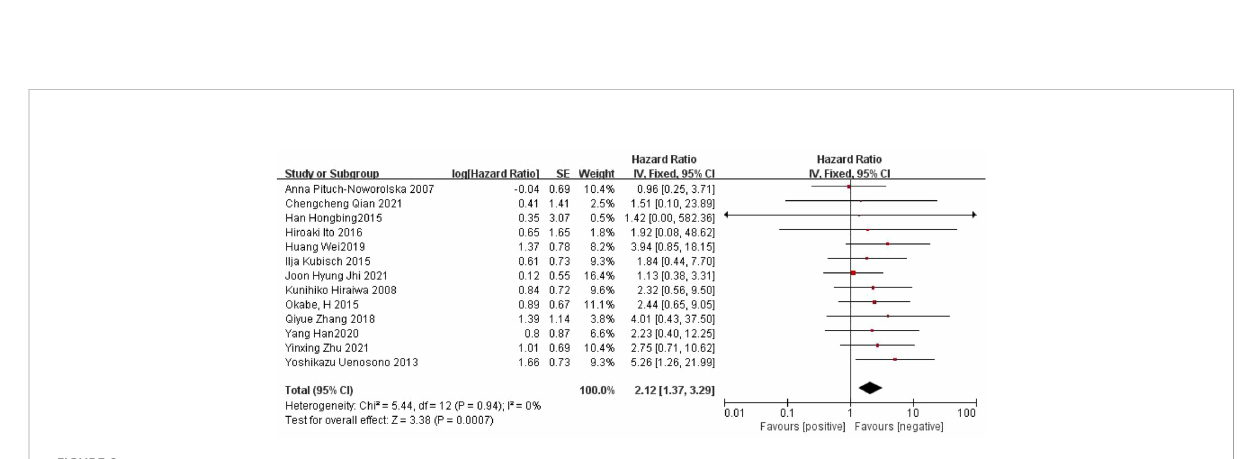
FIGURE 2 Meta-analysis of the relationship between CTC and